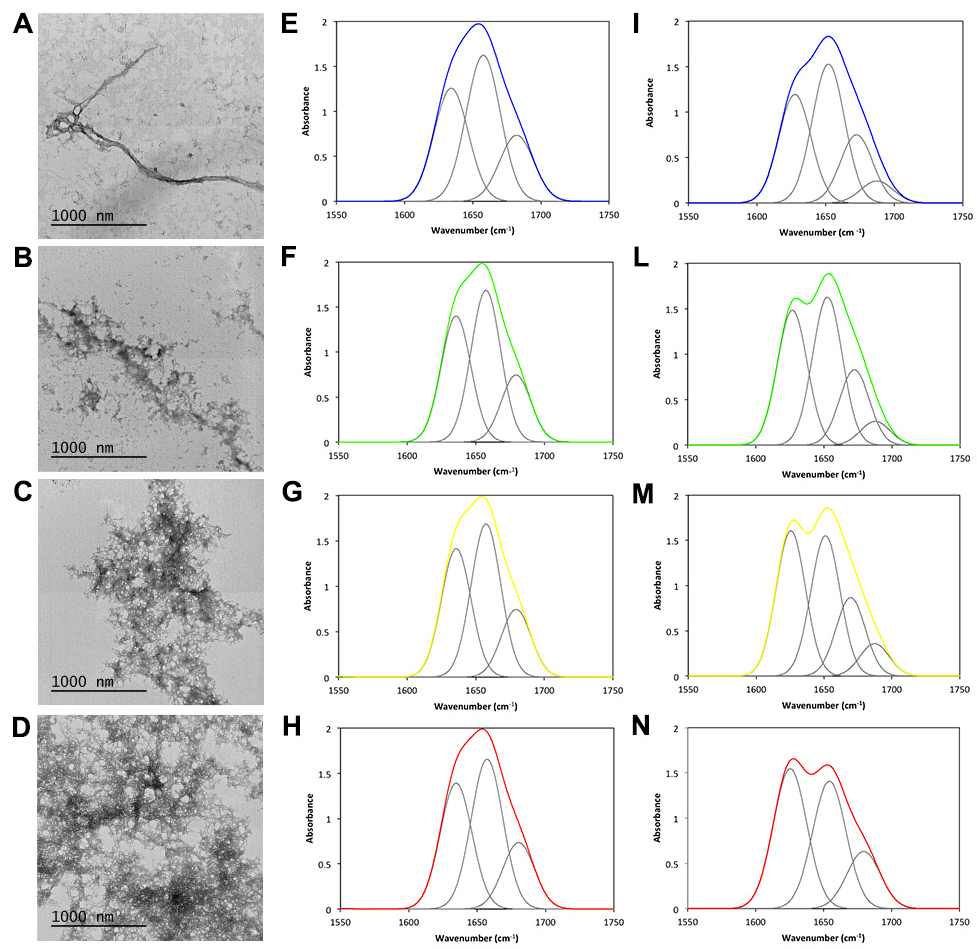
Figure 8. TEM and FTIR analyses of the JD aggregates in the presence of different TFE concentrations. ( A – D ) TEM images of negatively stained JD aggregates formed after 24 h of incubation at 37 °C in the presence of 0 ( A ), 1 ( B ), 2 ( C ) and 5% ( D ) TFE ( v / v ). ( E – I , L – N ) ATR/FTIR spectra of JD after 0 h ( E – H ) and 24 h ( I,L – N ) in the presence of 0%, 1%, 2% and 5% TFE ( v / v ). All the spectra were acquired in the amide I region and the fitted individual bands after Gaussian deconvolution are shown ( grey lines ).